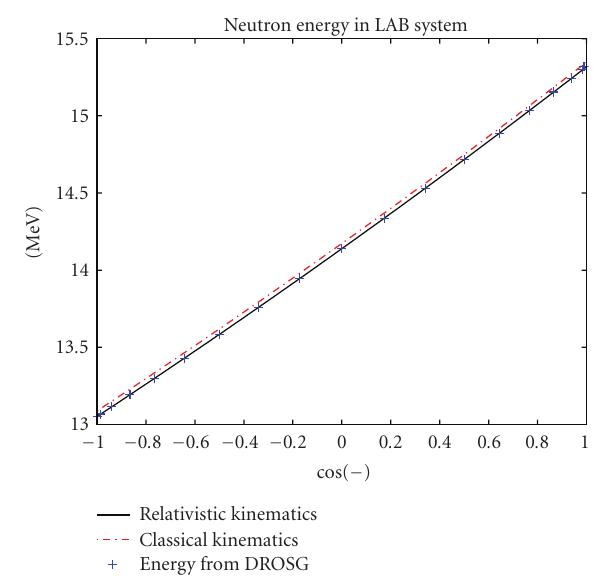
Neutron energy in LAB system